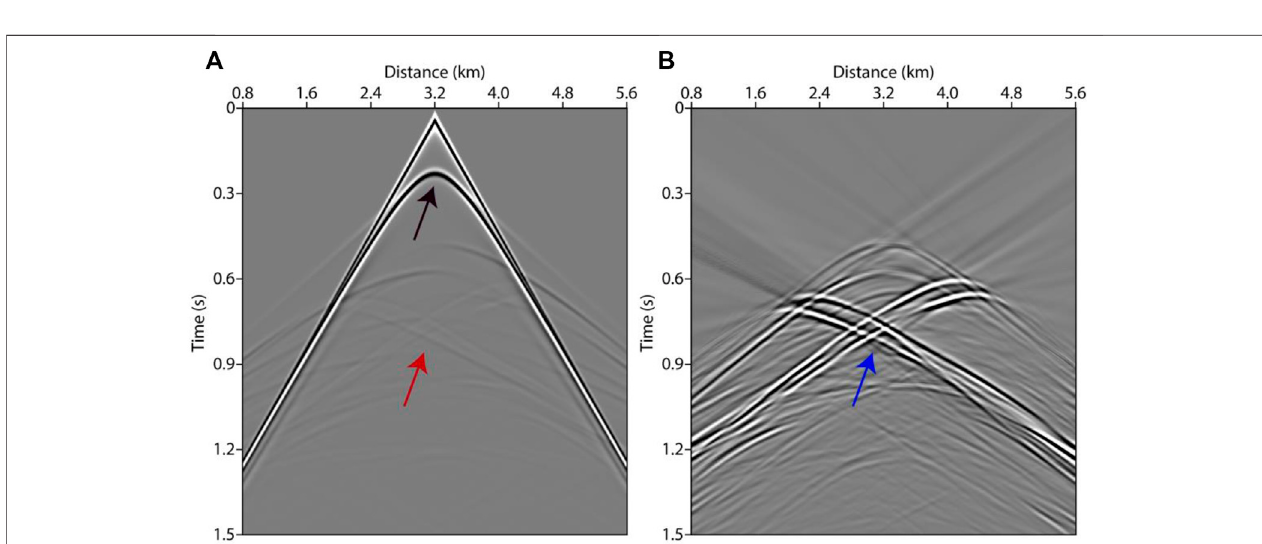
FIGURE 7 | Response of the point source. (A) full wave fi eld, and (B) diffraction wave fi eld.